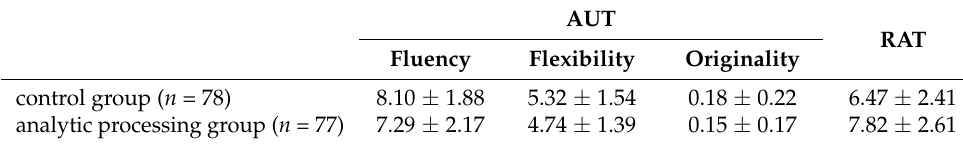
Table 1. Creativity task scores under different conditions ( M ± SD